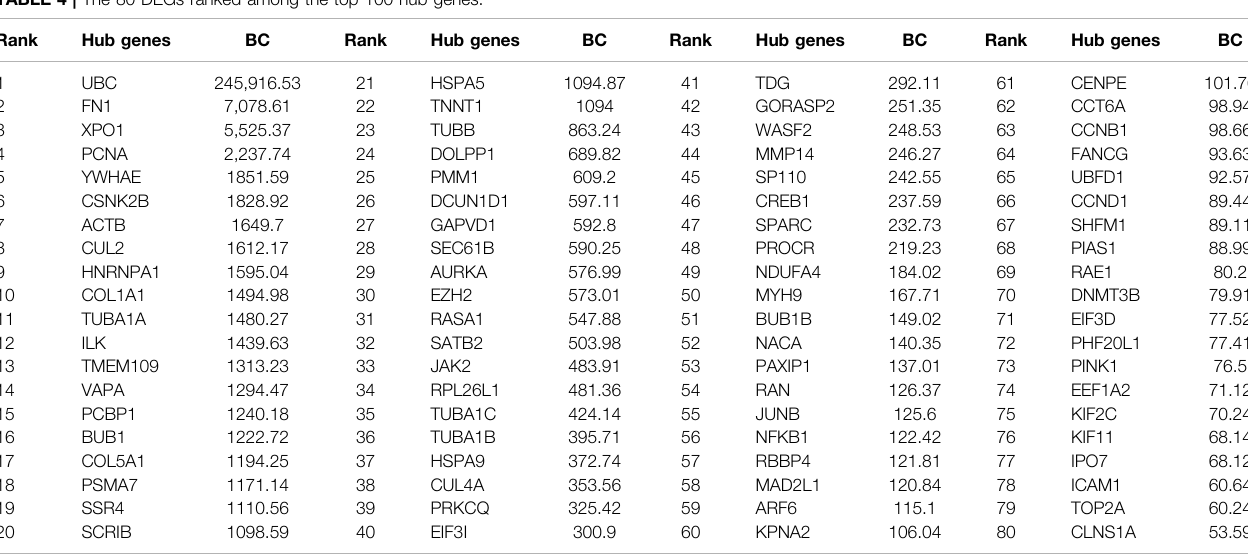
TABLE 4 | The 80 DEGs ranked among the top 100 hub